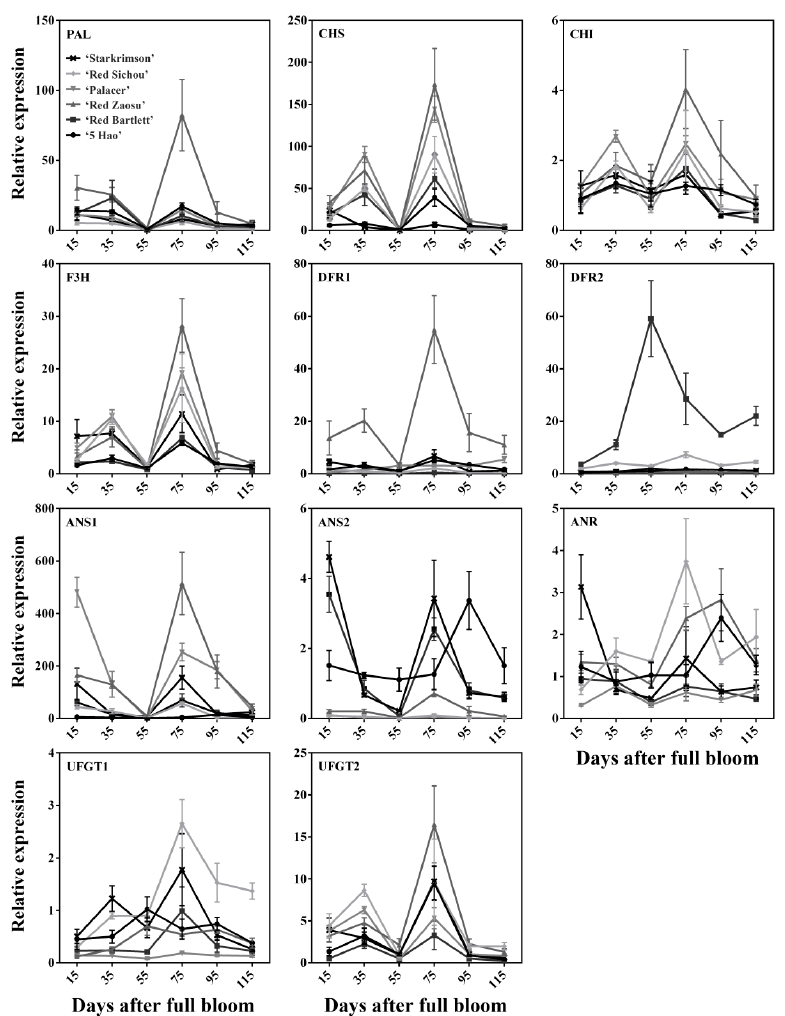
Figure 2. Relative expression levels of the anthocyanin biosynthesis-related structural genes of six red pear cultivars at different stages of fruit development.